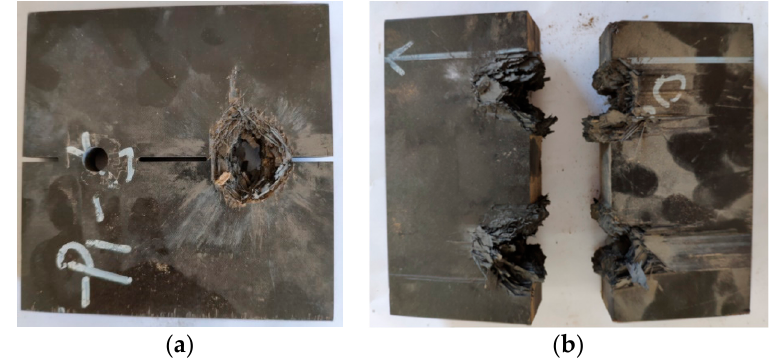
Figure 4. Normal opening charge blasting test results. ( a ) 15 mm; ( b ) 25 mm.